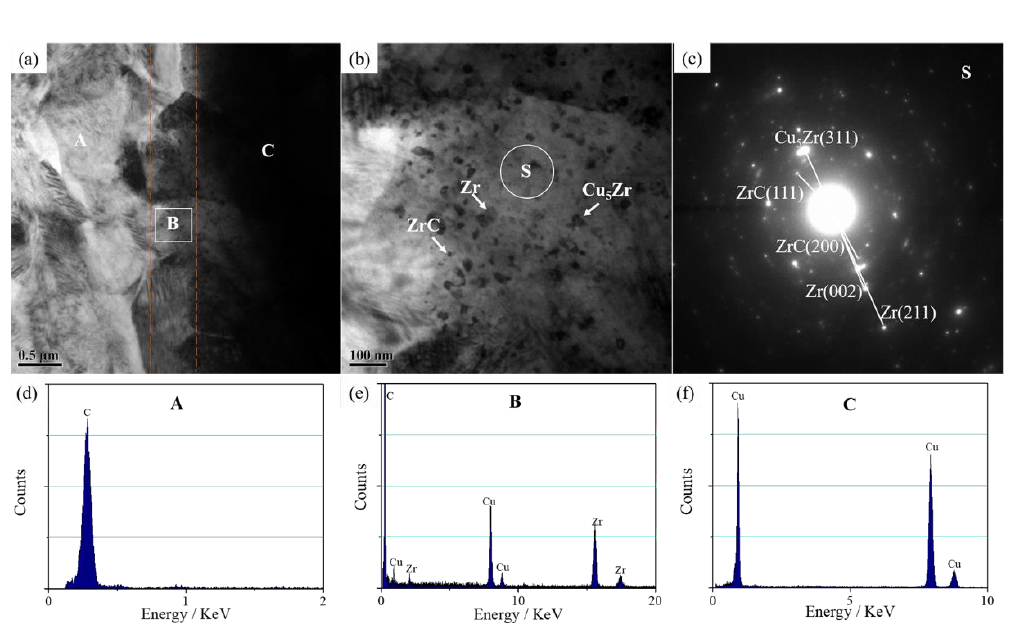
Figure 8. ( a ) Typical TEM image of interface in FG/Cu-2Zr composite; ( b ) magnified detail image of white rectangle in ( a ); ( c ) the electron diffraction pattern and analysis of the marked area S in ( b ); ( d – f ) EDS data of the marked points A, B, and C in ( a ), respectively.